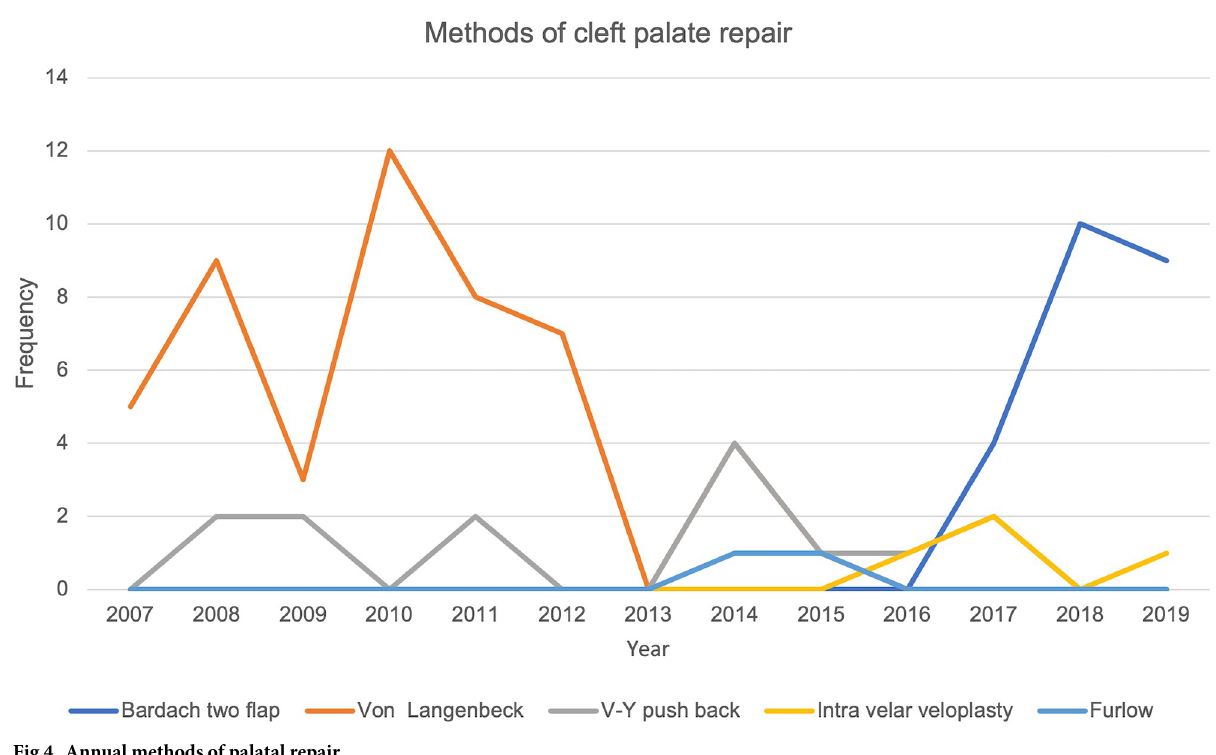
Fig 4. Annual methods of palatal